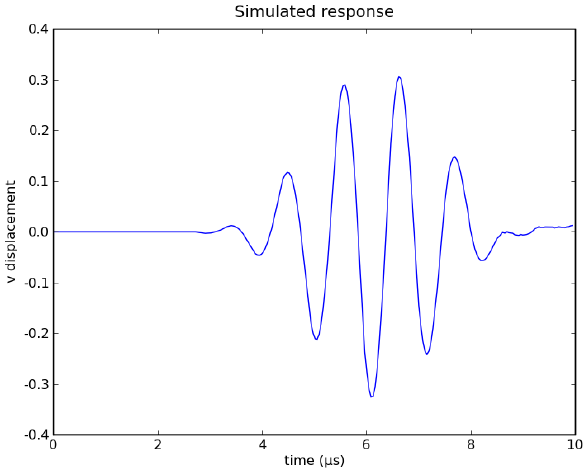
Fig. 8. Example of Lamb wave response from the analysed LISA model of the composite plate. The lowest error value was 6 3.41 10 